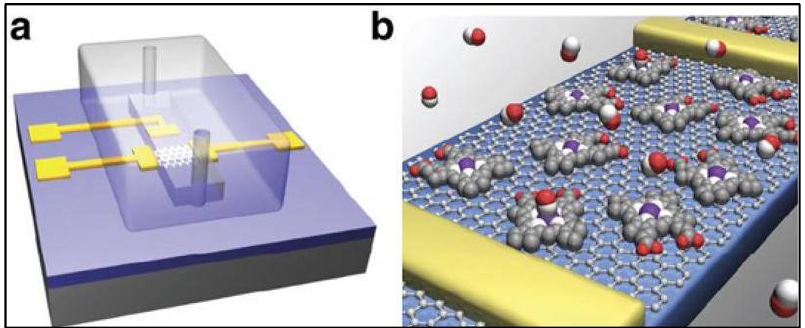
Figure 4. NO hemin-functionalized sensor. ( a ) PDMS channel with gold gate, source, and drain electrodes; ( b ) NO selective channel. Reprinted by permission from Springer Nature: Nature Communications reference [108]. Copyright